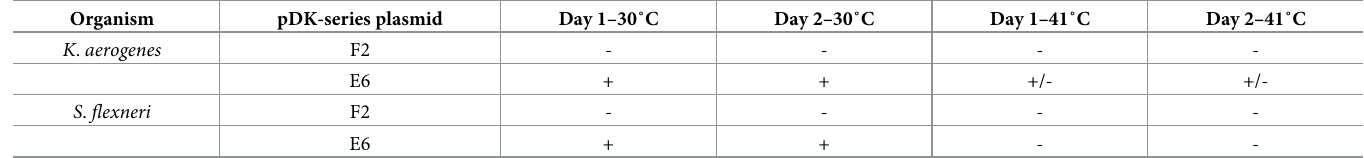
Table 5. Microscopic observation of PHA granules in enteric bacteria (pUMS, pDK-plasmid). Organism